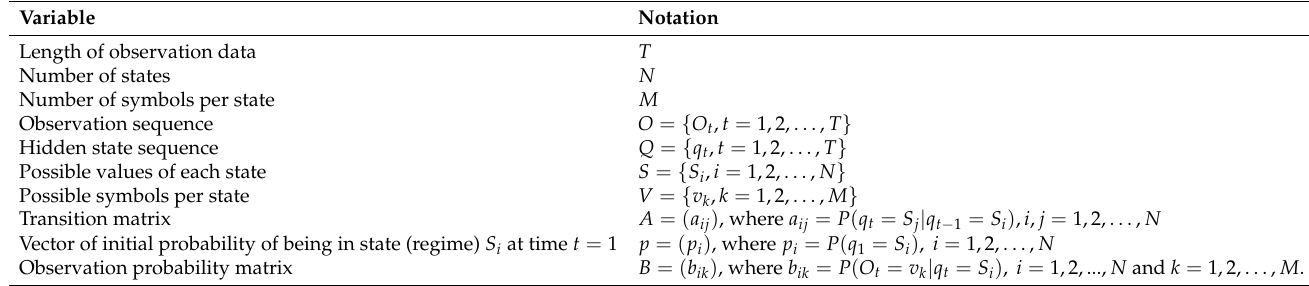
Table 1. Basic concepts of a hidden Markov model.